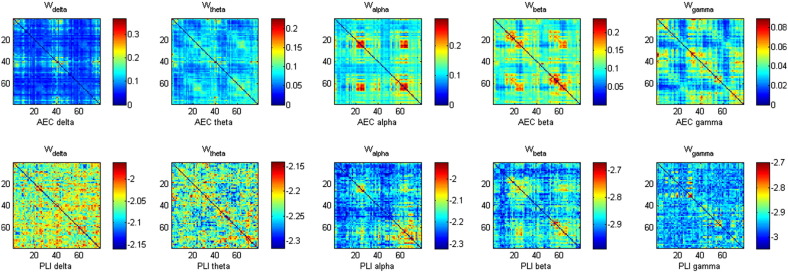
MEG connectivity matrices for the second dataset. Illustrated are the AEC (upper row) and PLI (bottom row) connectivity matrices for the different frequency bands. Note that the AEC matrices contain clearer structure. The alpha and beta band PLI and AEC matrices do seem to contain similar patterns, i.e. four blocks around areas 20 and 60 which are posterior regions. The gamma band lacks structure for both functional connectivity matrices. Note that in comparison to Fig. B10 the gamma band connections are less clear, in contrast to theta band connections which are more prominent. This could have several reasons, such as MEG system type, eyes-open versus eyes-closed recordings or differences in cohorts. Notice that the PLI matrix is transformed by taking the natural logarithm of all values to increase the range of the values.